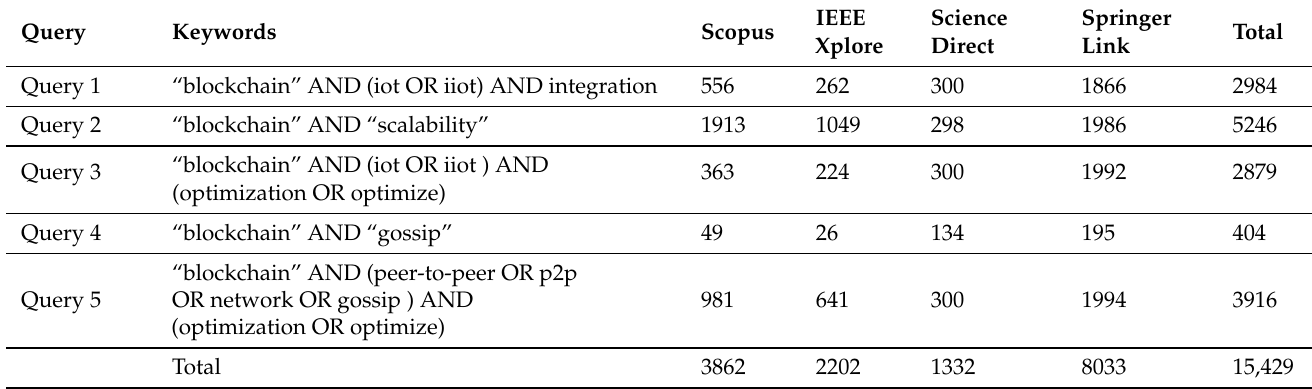
Table 2. Total Number of References Imported into the Reference Manager.